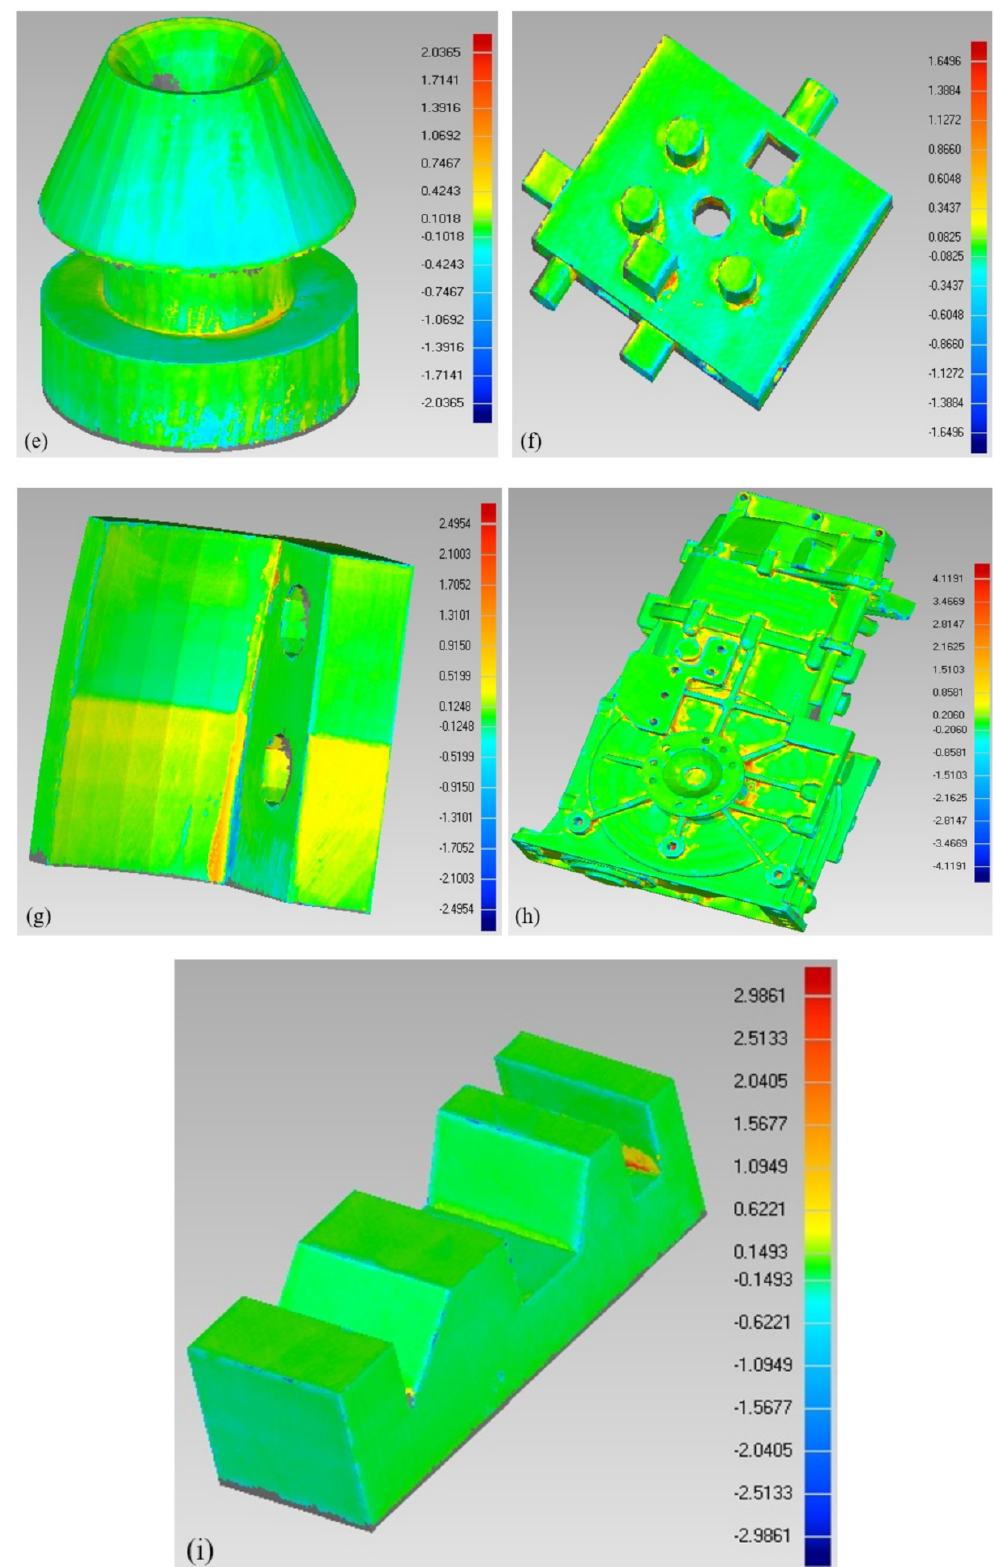
Figure 13. Deviation between the 3D printed parts and their CAD models from the 3D